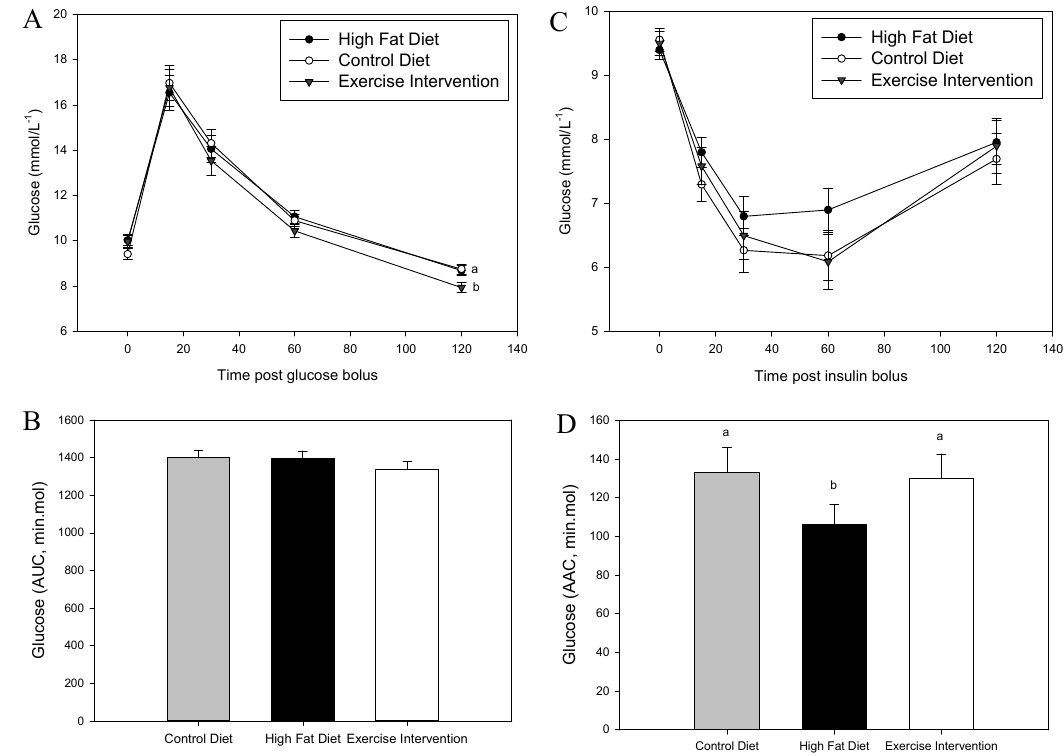
Figure 2. Effect of paternal high fat diet with exercise interventions on male offspring response to a glucose and insulin challenge (8–9 weeks). ( A ) Glucose tolerance as assessed by glucose tolerance test (GTT, 2 g/kg); ( B ) Glucose area under the curve (AUC, min ∙ mmol) during GTT ( C ) Insulin tolerance as assessed by the insulin tolerance test (ITT, 0.75 IU) and ( D ) glucose area above the curve (AAC, min · mol) during ITT. Data is expressed as mean ± standard error mean. n = 10 male offspring from n = 10 litters representative of n = 8 fathers per group. a, b Different letters denote significance at p < 0.05.